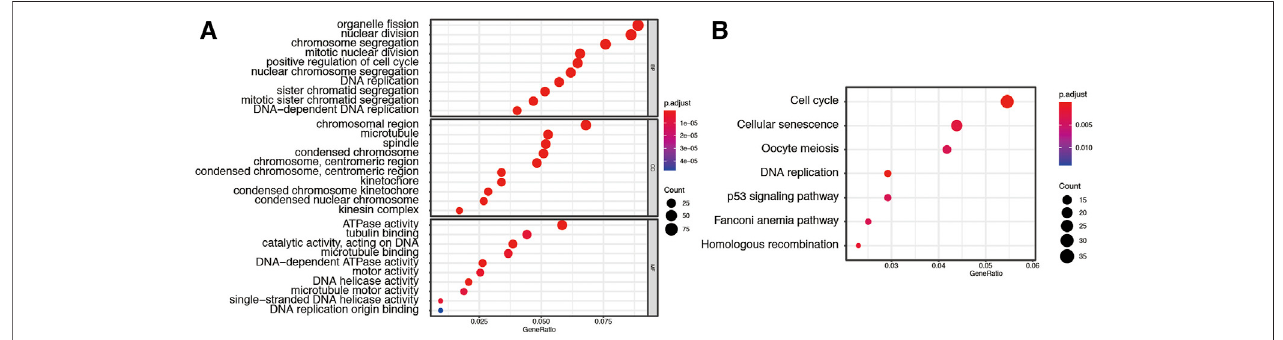
FIGURE 3 | Functional analysis for genes in turquoise module. (A) Representative results of GO analysis. (B) Representative results of KEGG